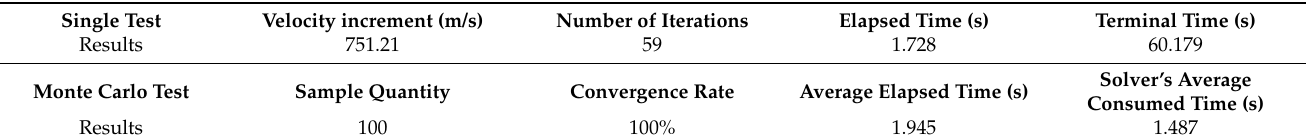
Table 8. The result of Example 2.